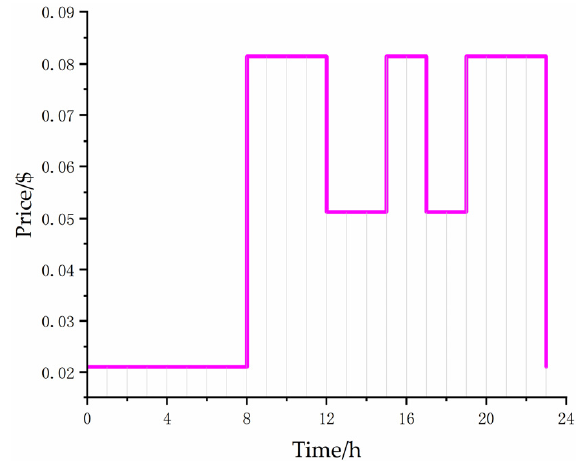
Figure 3. Profile of price fluctuations.